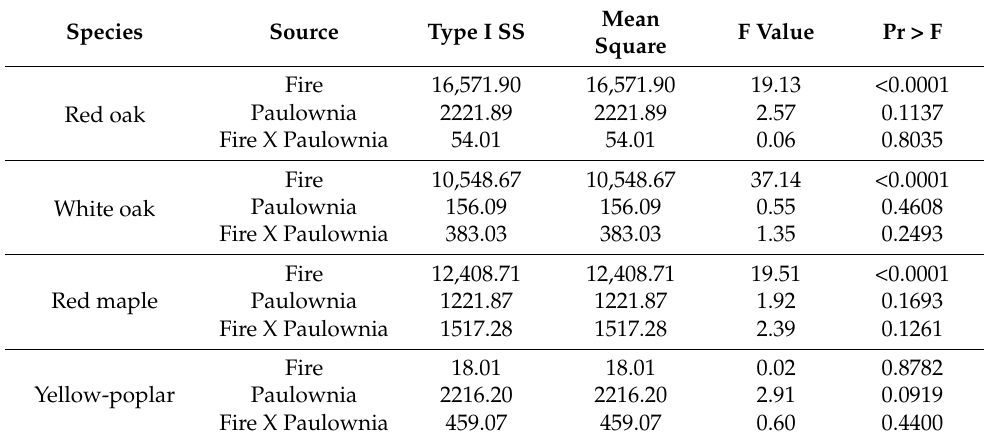
Table 5. Statistics of the two-way ANOVA examining the effects of fire (fire/no fire), paulownia (presence/absence), and their interactions by species on the variation of height (<137cm)